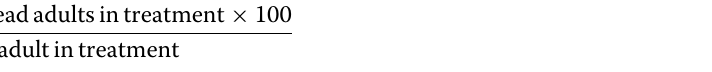
Table 2 Virulence effect of the applications on 1st and 2nd larval instars of Cymbalophora rivularis